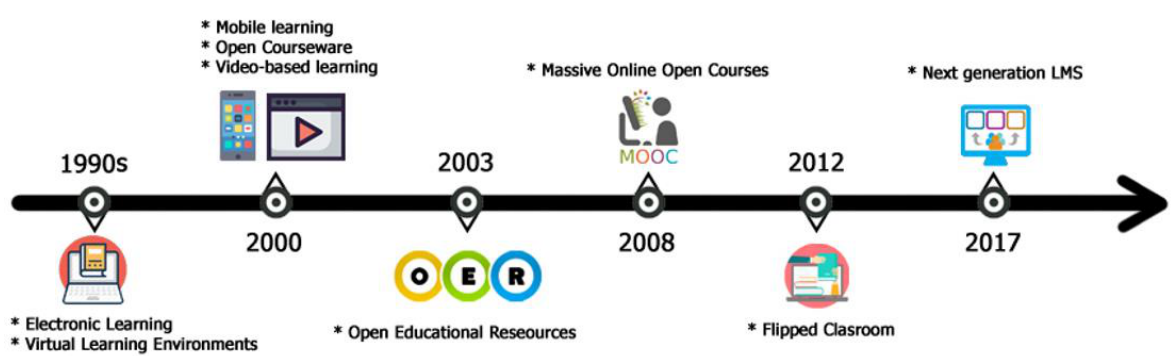
Figure 1 . The emergence of computer and internet